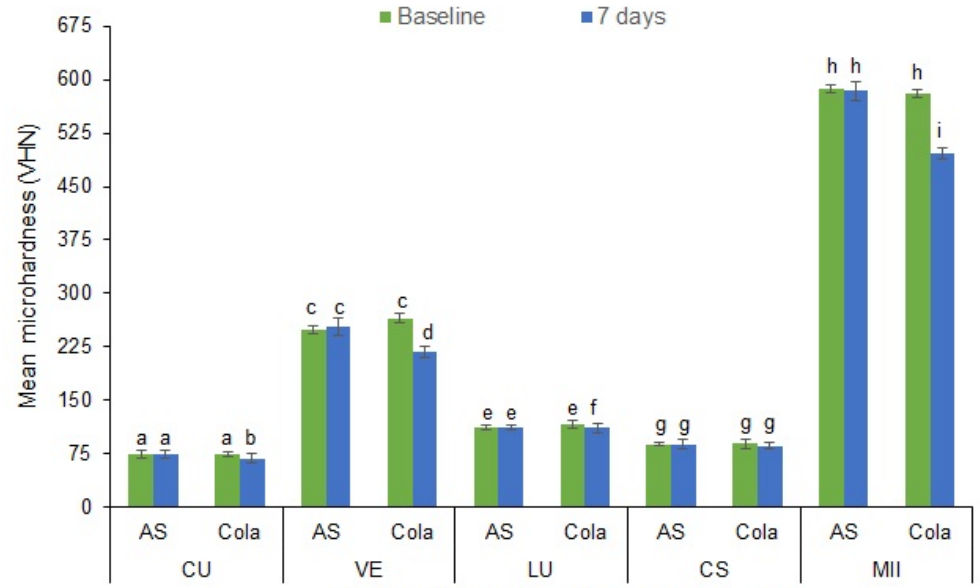
Figure 2. Mean microhardness (VHN) values of the CAD/CAM materials immersed in AS and cola at baseline and after 7 days immersion in either AS or cola. Bars indicate standard deviation. Post-hoc interpretation: Same lower-case alphabet shows the non-significant difference between the CAD/CAM material